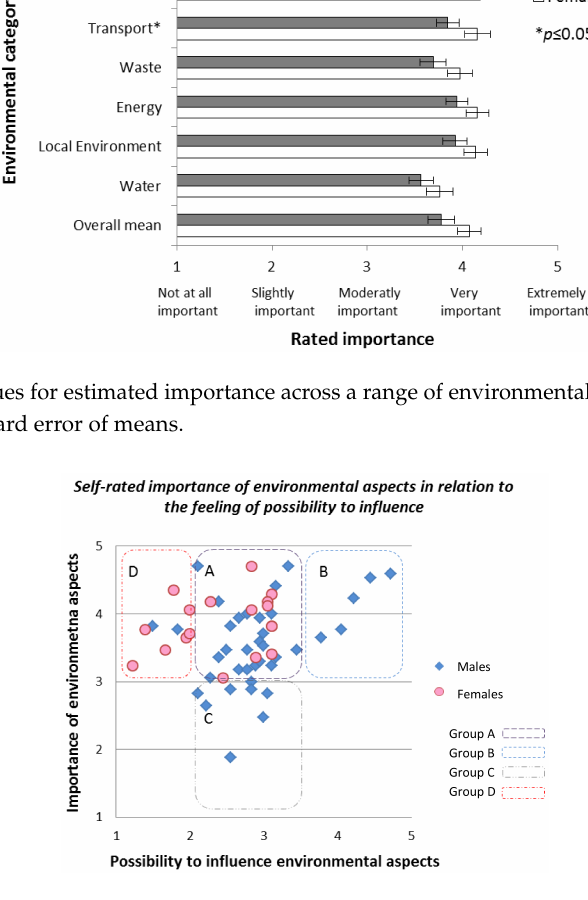
Figure 3. Self-rated mean values of the importance of environmental aspects in the Kiruna project and self-rated possibility to influence the competition